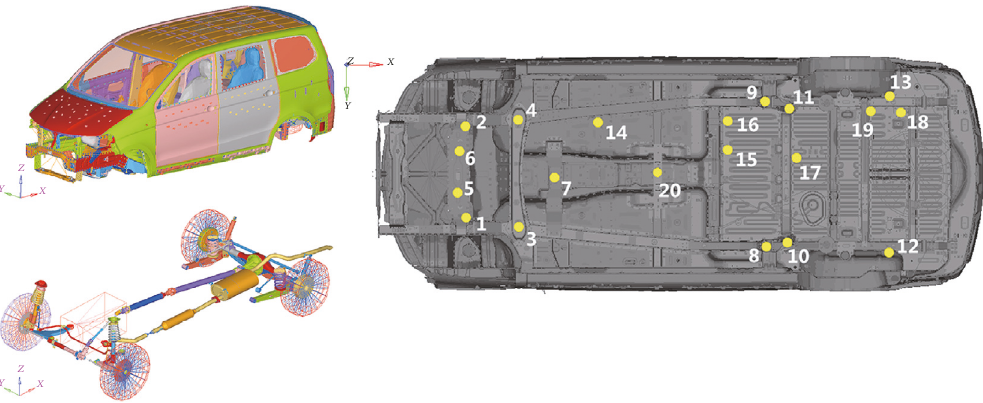
Figure 10: Substructures and connection point.